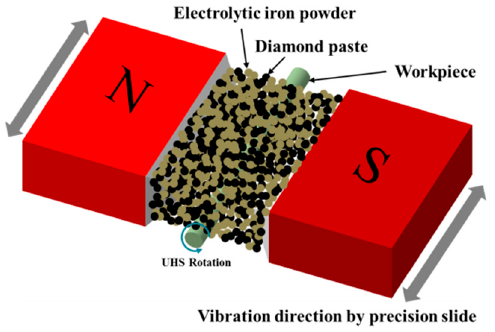
Figure 1. Schematic of the processing principles of cylindrical magnetic abrasive machining.